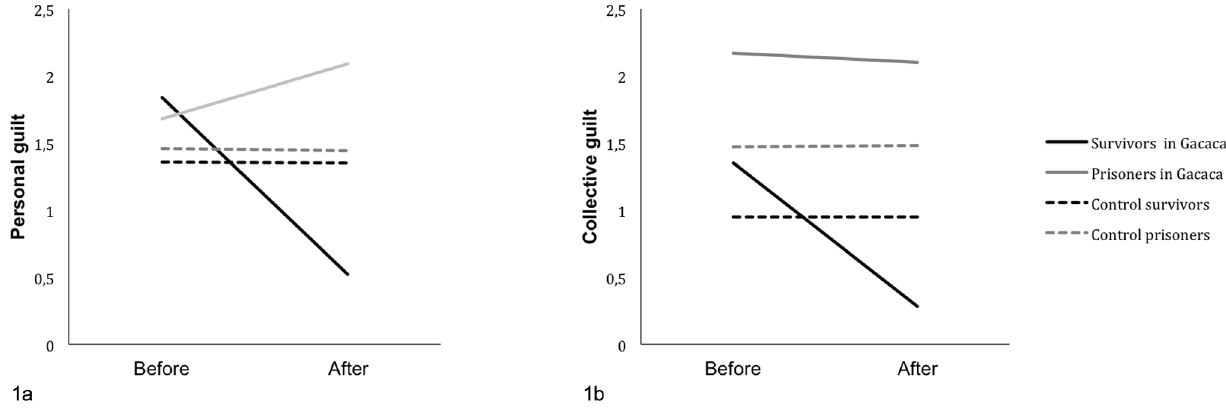
Figure 1. Level of personal guilt (1a) and collective guilt (1b) reported by the respondents of the four groups before and after participation of two of these groups in